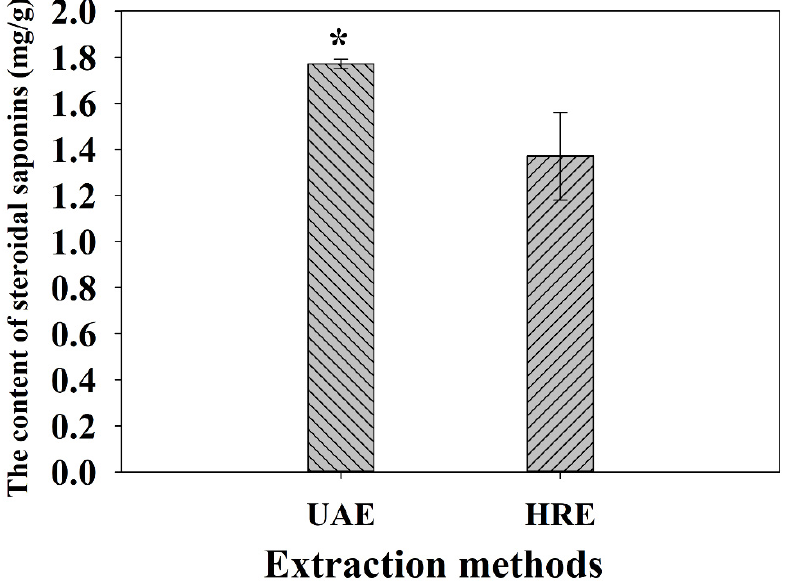
Figure 1. Effect of the extraction methods on the yield of total steroidal saponins. * represents the difference between UAE and HRE, p ≤ 0.05. Error bars indicate mean values ± SD, ( n = 3).